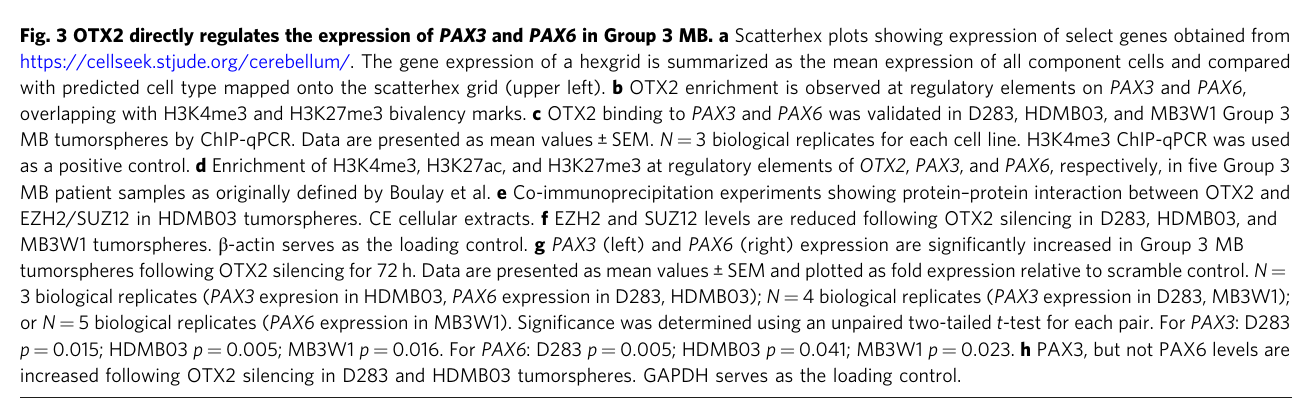
Fig. 3 OTX2 directly regulates the expression of PAX3 and PAX6 in Group 3 MB. a Scatterhex plots showing expression of select genes obtained from https://cellseek.stjude.org/cerebellum/. The gene expression of a hexgrid is summarized as the mean expression of all component cells and compared with predicted cell type mapped onto the scatterhex grid (upper left). b OTX2 enrichment is observed at regulatory elements on PAX3 and PAX6 , overlapping with H3K4me3 and H3K27me3 bivalency marks. c OTX2 binding to PAX3 and PAX6 was validated in D283, HDMB03, and MB3W1 Group 3 MB tumorspheres by ChIP-qPCR. Data are presented as mean values ± SEM. N = 3 biological replicates for each cell line. H3K4me3 ChIP-qPCR was